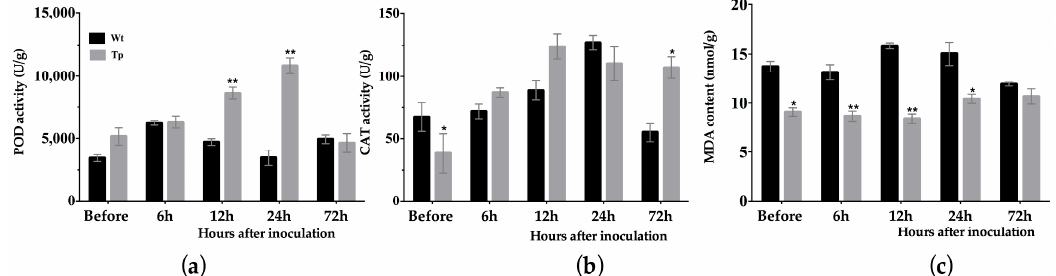
Figure 4. Determination of physicochemical indexes in E. cichoracearum DC.-inoculated, transgenic ( n = 3) and wild-type ( n = 3) tobacco plants. ( a ) Peroxidase (POD) activity; ( b ) catalase (CAT) activity; ( c ) malondialdehyde (MDA) content. Wt, wild-type; Tp, transgenic plant. Error bars indicate SE, and * and ** indicate significant differences at p < 0.05 and p < 0.01, respectively.